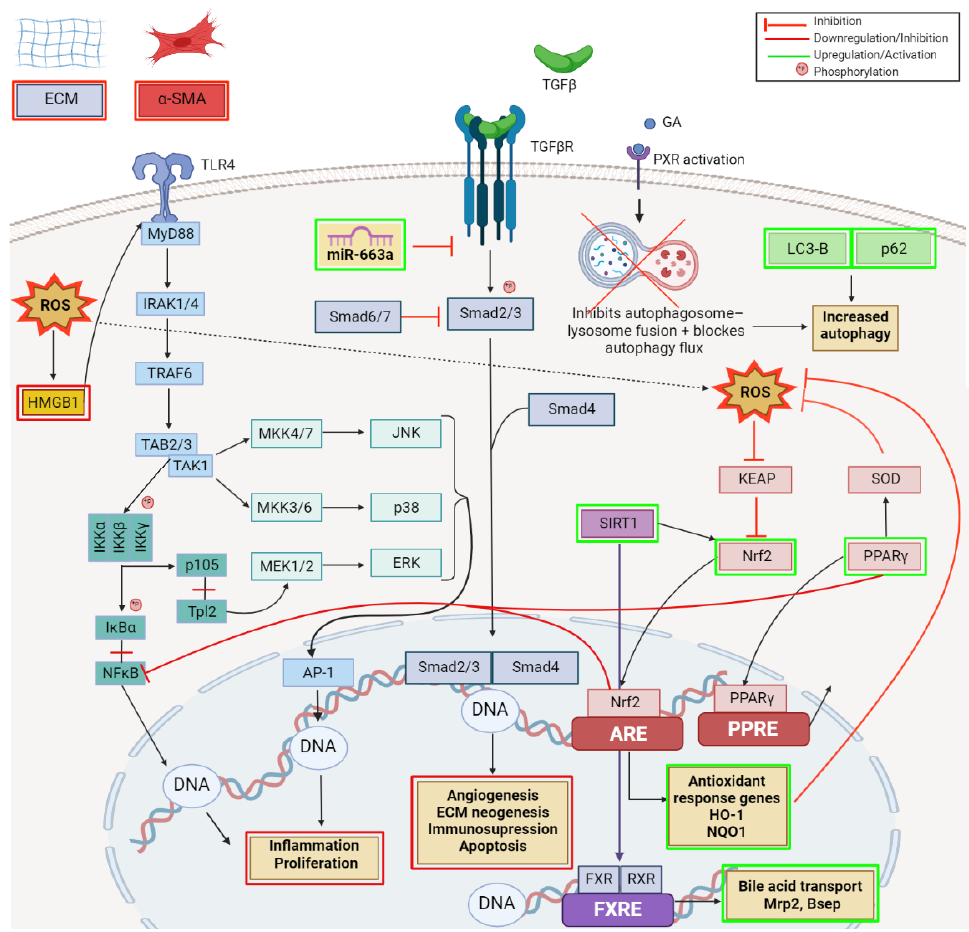
Figure 12. Schematic representation of the reported hepatoprotective mechanisms of glycyrrhetinic acid; key signaling pathways targeted. Created with BioRender.com (accessed on 23 June 2022).